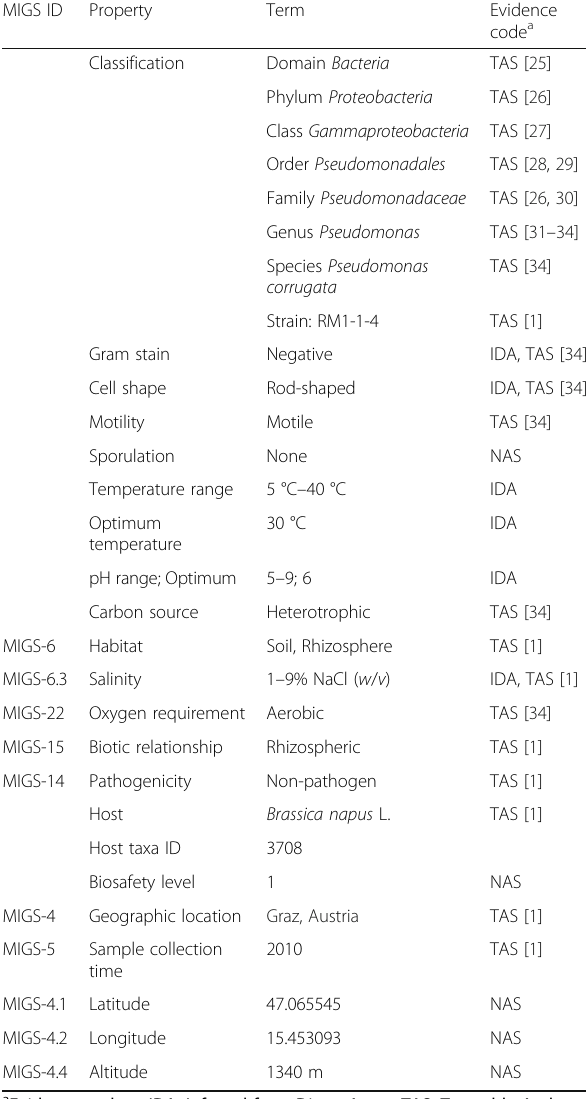
Table 1 Classification and general features of P. corrugata RM1- 1-4 according to the MIGS recommendation